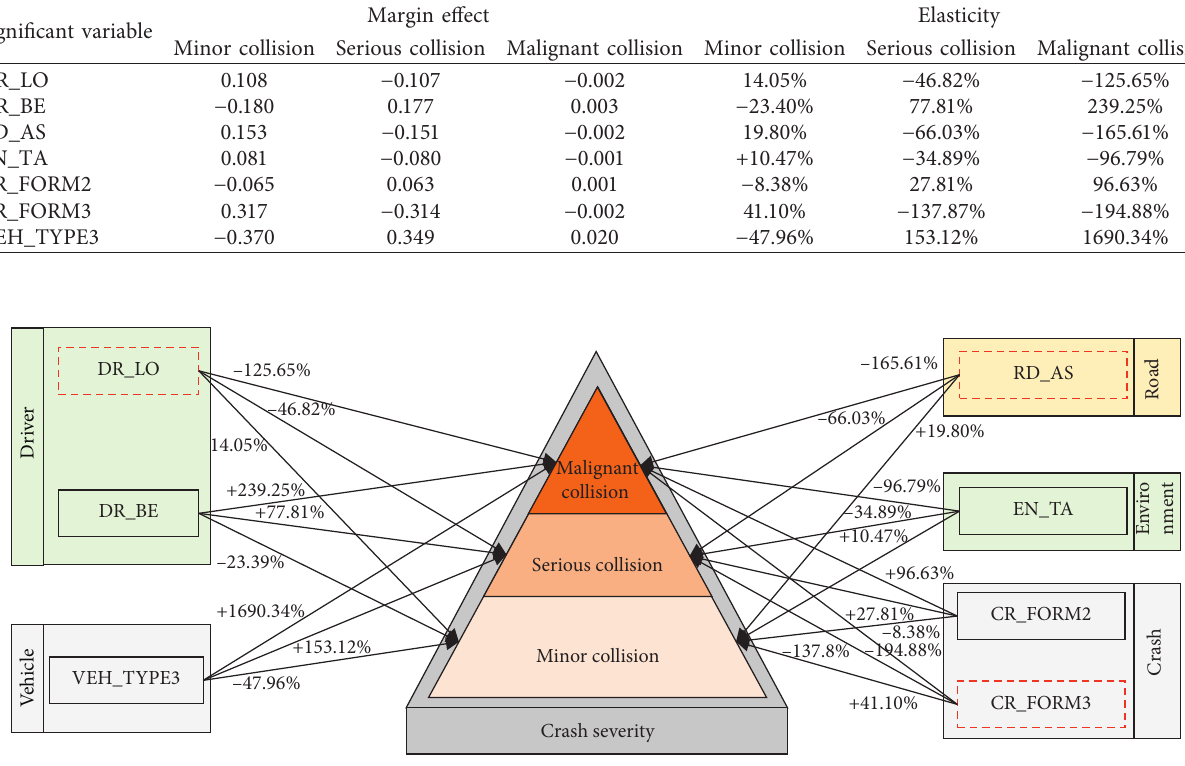
Figure 6: The influence mechanism of significant variables